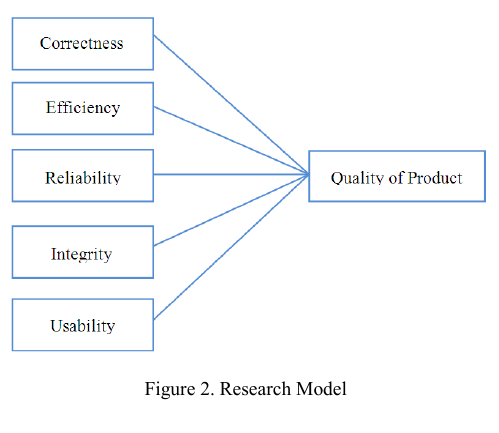
Figure 2. Research